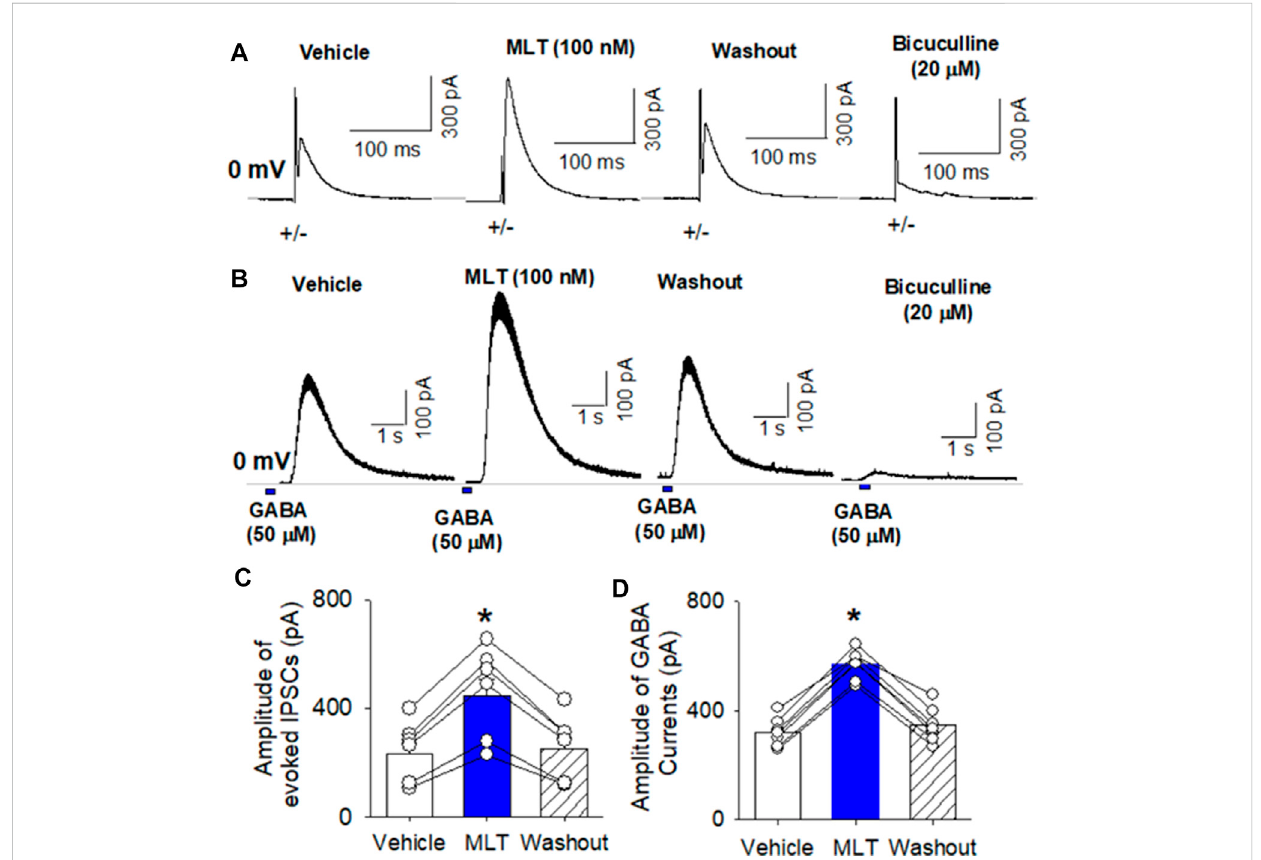
FIGURE 3 Effect of melatonin on GABAA receptor activity in RVLM projecting PVN neurons. (A,B) , Representative raw tracings show that melatonin at concentration of 100 nM increased the amplitude of evoked GABAergic IPSCs (A) and the currents induced by puff application of 100 μ M GABA (B) onto the labeled RVLM projecting PVN neurons recorded. Please note that application of 20 μ M bicuculline abolished evoked IPSCs and puff GABA-induced currents. (C,D) , Summary data show that 100 nM melatonin signi fi cantly increased the amplitude of evoked IPSCs (n = 6 neurons from 3 rats) and puff GABA-induced currents (n = 6 neurons from 3 rats). Data are mean ± SEM. One-way ANOVA with the Bonferroni ’ s post hoc test was used to determine differences between groups * p < 0.05 compared with the basal values in each group. MLT,